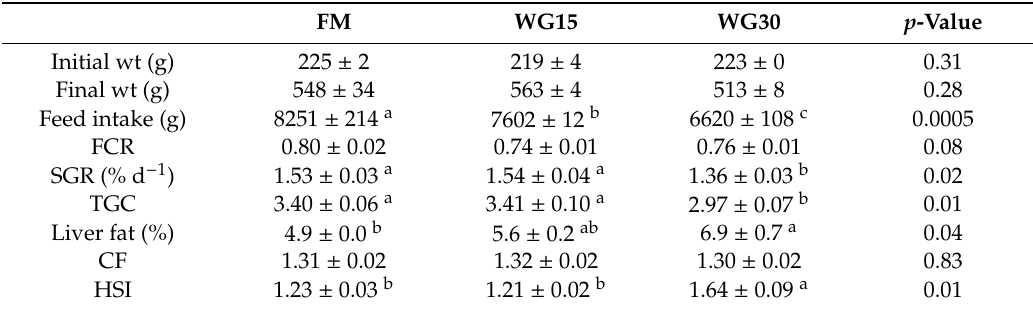
Table 2. Body weights (bw) at study start and end, feed intake, feed conversion ratios (FCR), specific growth rates (SGR), and thermal growth coe ffi cients (TGC) of Atlantic salmon (mean ± S.E.M.; n = 3 replicate tanks) fed with control diet (FM) or WG-containing diets (WG15, WG30). Liver fat contents, condition factors (CF), and hepatosomatic index (HSI) of sampled fish, mean ± S.E.M.; n = 15, five fish per three replicate tanks.